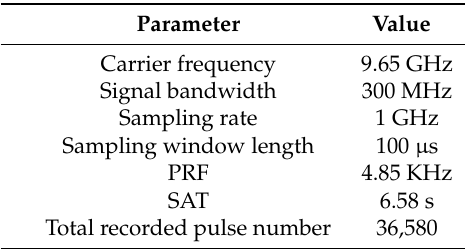
Table 1. Experimental parameters.